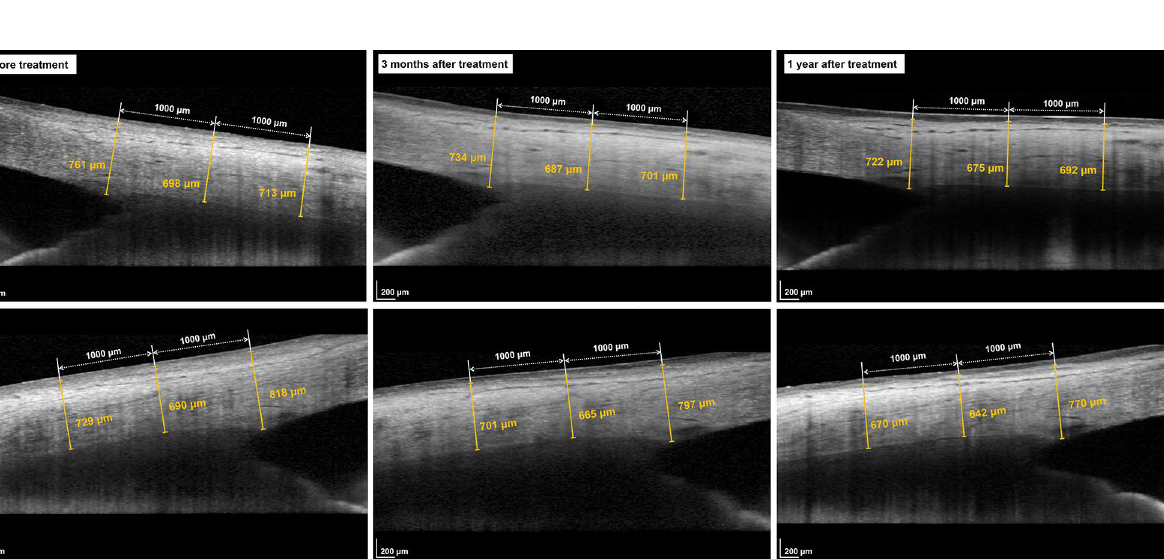
Table 4. Comparison of two groups according to the IOP reduction percentage in prostaglandins medication group. IOP intraocular pressure, CCT central corneal thickness, AXL axial length, MD mean deviation, RNFL retinal nerve fiber layer, AST anterior scleral thickness. a Independent t-test, b Mann-Whitney U test.